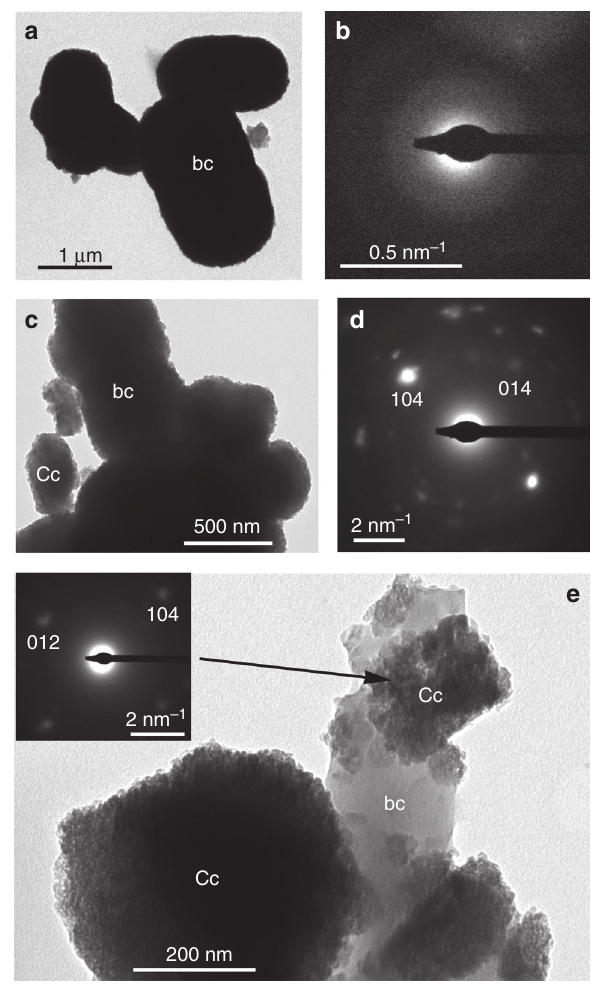
Fig. 3 TEM analysis of bacterial calcium carbonate precipitates. a After 17 h incubation time bacterial cells (bc) are covered by nanoparticle precipitates; b SAED pattern of the structures in a showing diffuse haloes demonstrating the amorphous nature of such precipitates; c after 48 h incubation time, larger precipitates made up of nanoparticles are observed (cid:1) (cid:3) around the bacterial cells; d the 441 -zone axis SAED pattern of precipitates in c shows they are single-crystalline calcite (Cc); e detail of (cid:1) (cid:3) calcite precipitates ( 421 -zone axis SAED pattern in inset) formed around bacterial cells. Note their nanogranular porous